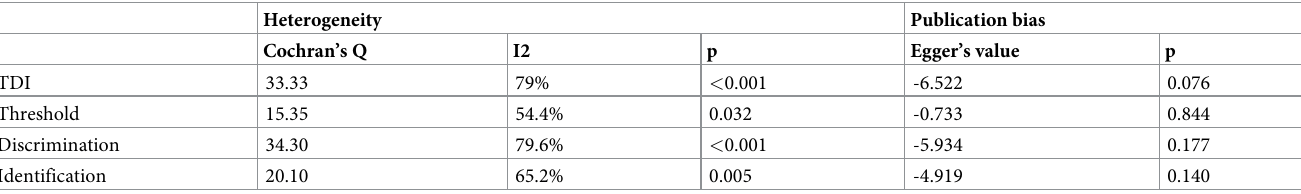
Table 3. Level of heterogeneity and publication bias amongst the included